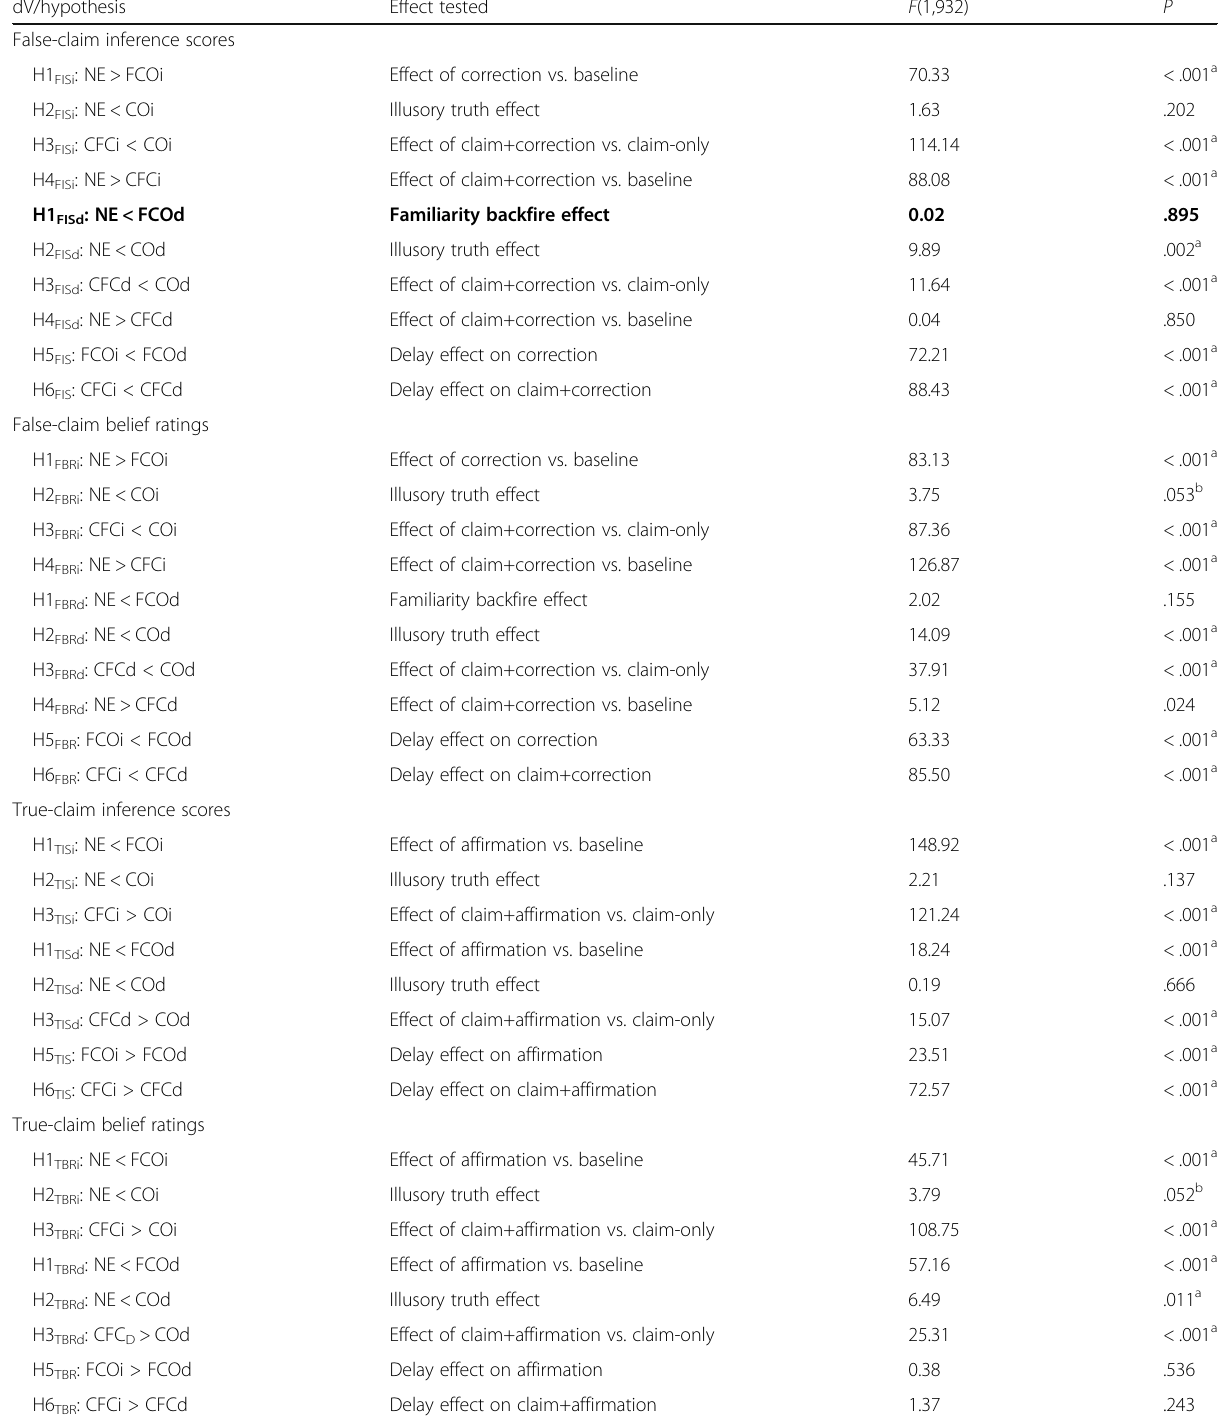
Table 2 Contrasts run in Experiment